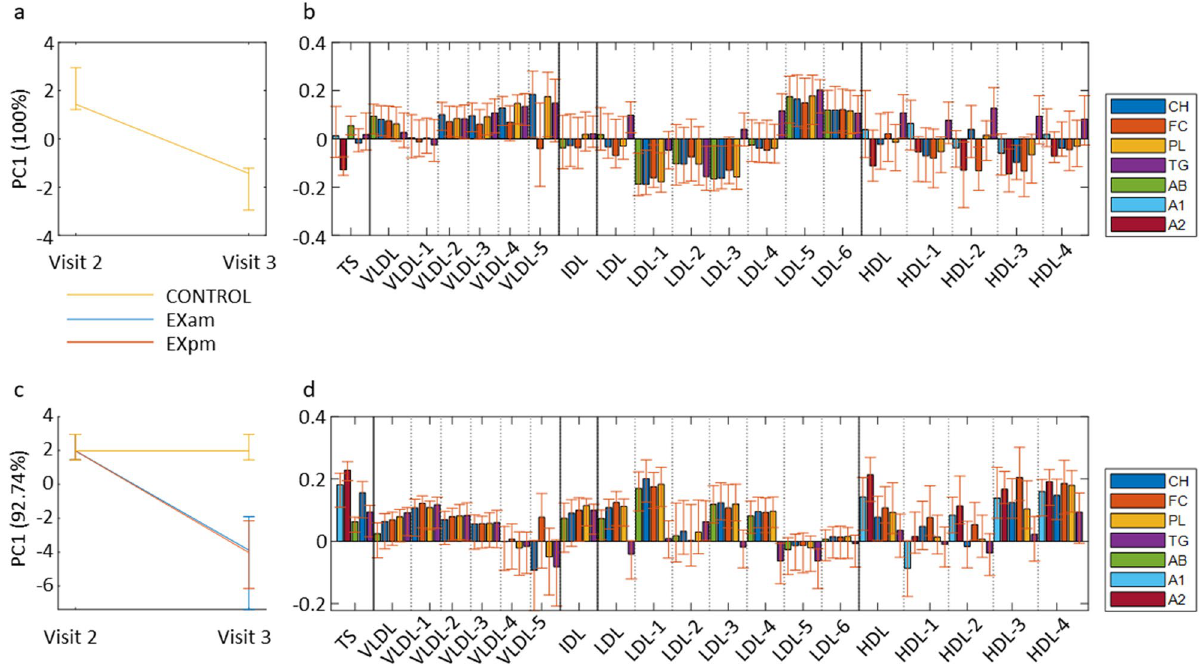
Figure 5. Changes after continued high-fat diet with and without exercise training. Scores and loading plots from repeated measures ANOVA simultaneous component analysis for discriminating lipoprotein profiles after exercise/no exercise for 5 days (Visit 3) from after 5 days of high-fat diet (Visit 2), in the fasted state. ( a ) Scores for changes between Visit 2 and Visit 3 in the control group (CONTROL), ( b ) Loadings for changes between Visit 2 and Visit 3 in the control group, ( c ) Scores for changes after morning exercise (EXam) and evening exercise (EXpm) between Visit 2 and Visit 3, compared with changes in the control group, ( d ), Loadings for changes after morning exercise (EXam) and evening exercise (EXpm) between Visit 2 and Visit 3, compared with changes in the control group. CH = cholesterol, FC = free cholesterol, PL = phospholipids, TG = triglycerides, AB = Apolipoprotein-B100, A1 = Apolipoprotein A-1, A2 = Apolipoprotein